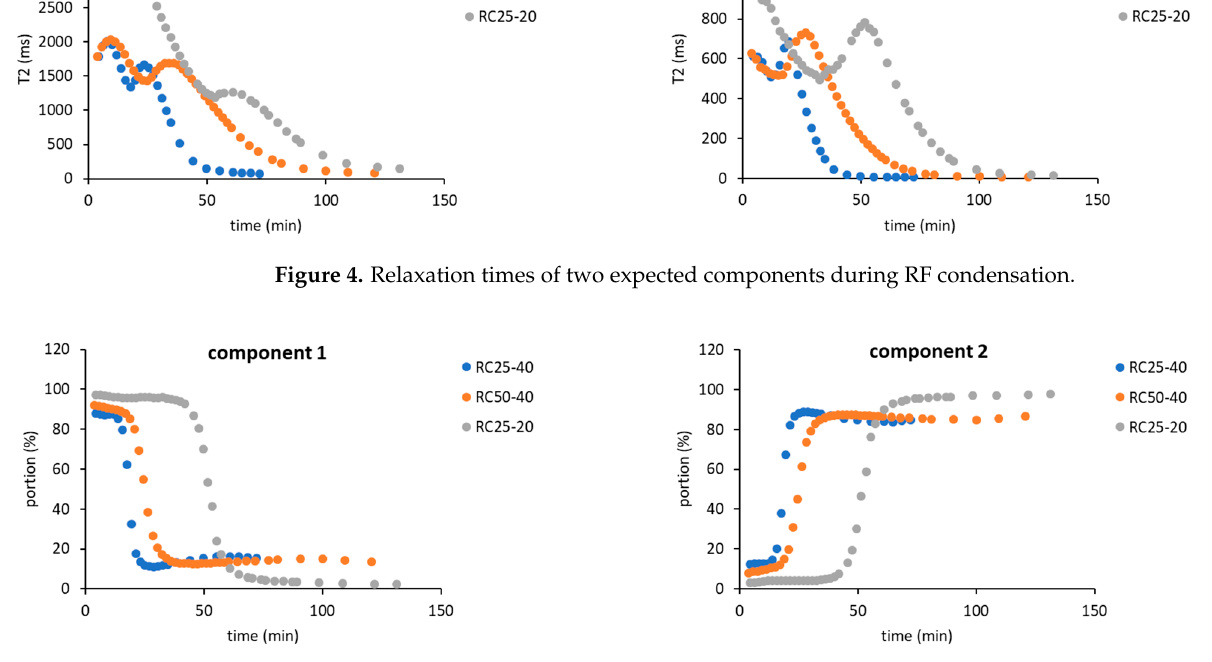
Figure 5. Content of two expected components during RF condensation.